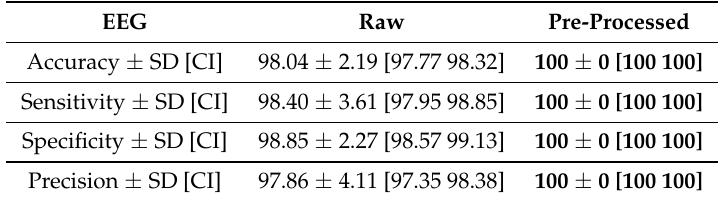
Table 8. Accuracy, Sensitivity, Specificity and Precision for Raw and Pre-processed electroencephalogram (EEG) using LSTM ECOC-SVM. (The Numbers in Bold Indicate the Best Value Obtained for Each Quality